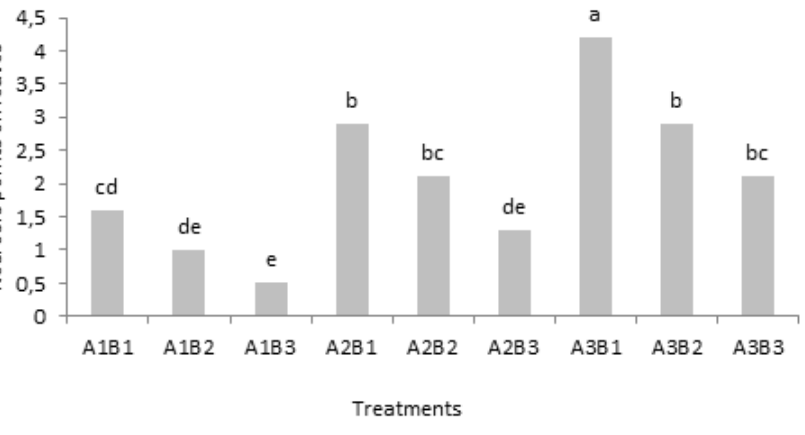
Figure 3: Number of necrotic points on leaves of Judas tree plants under lead and nitrate interaction treatments. Treatments indicate lead levels (A: 0, 15, 30 mg L -1 ) and nitrate levels (B: 0, 50, 100 mg L -1 ). Data are average of four replications ±SD. Comparison of means was done at 5% level of LSD